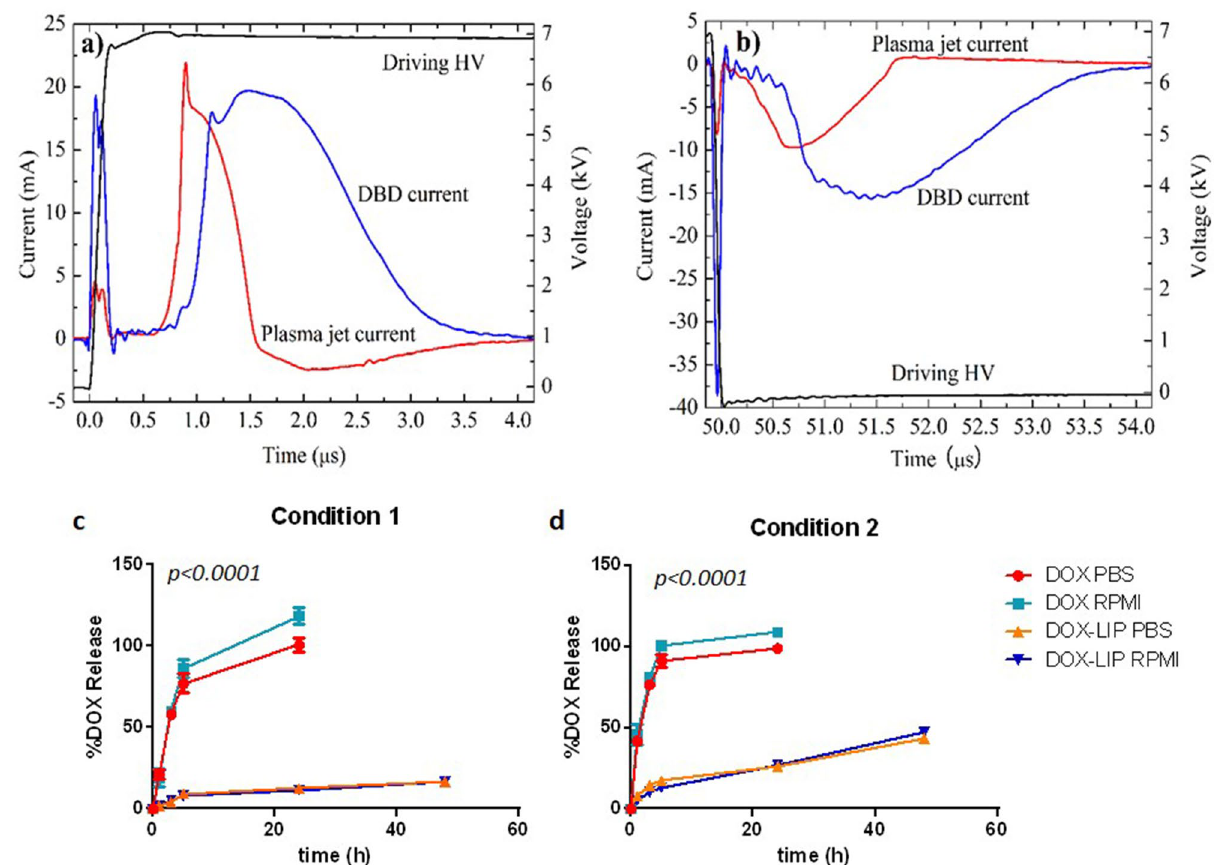
Figure 1. Representative waveforms of the driving pulsed high voltage, and the induced DBD and plasma jet currents, during: ( a ) The positive slope of the voltage pulse; ( b ) The negative slope of the voltage pulse. The records are carried out in situ, i.e. during specimen treatment. Release (% of total) of DOX from the liposomes during incubation for up to 48 h (at 37 °C), in PBS and RPMI 1640. ( c ) Release in Condition 1, 0.5 ml